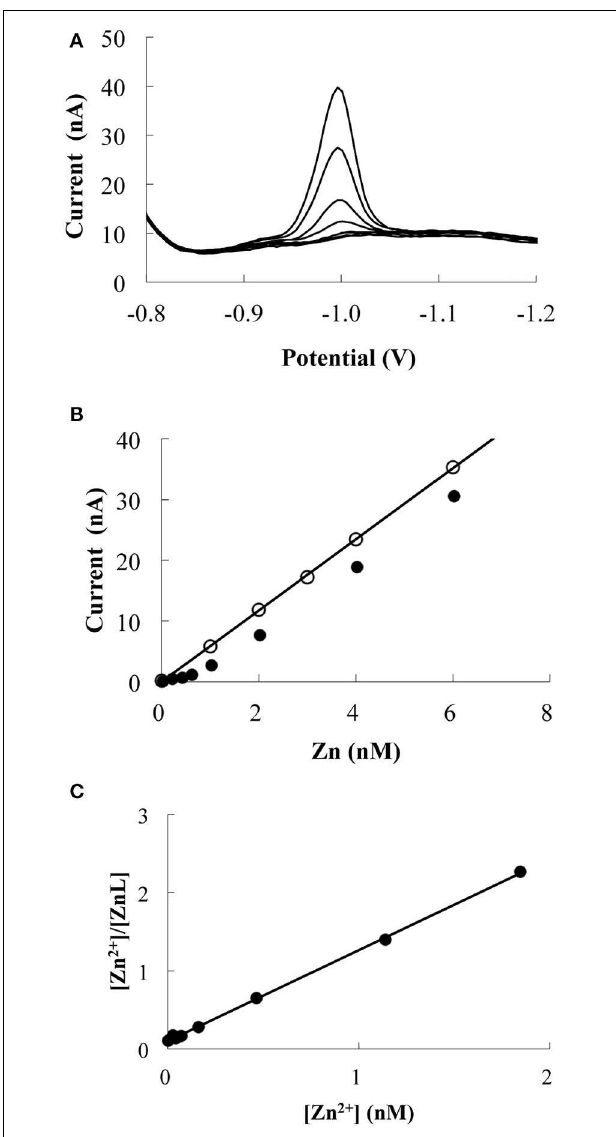
FIGURE 2 | Example of Zn titration data (MY-6, 15m). (A) Voltammetric scans for Zn additions. (B) The response of Zn peak current with increasing Zn additions. The line and blank circles indicate the response of UV-irradiated sample. (C) Linear relationship obtained by transforming the titration data. The calculated C L and log K ′ were 0.9nM and 10.1, ZnL , Zn2 +